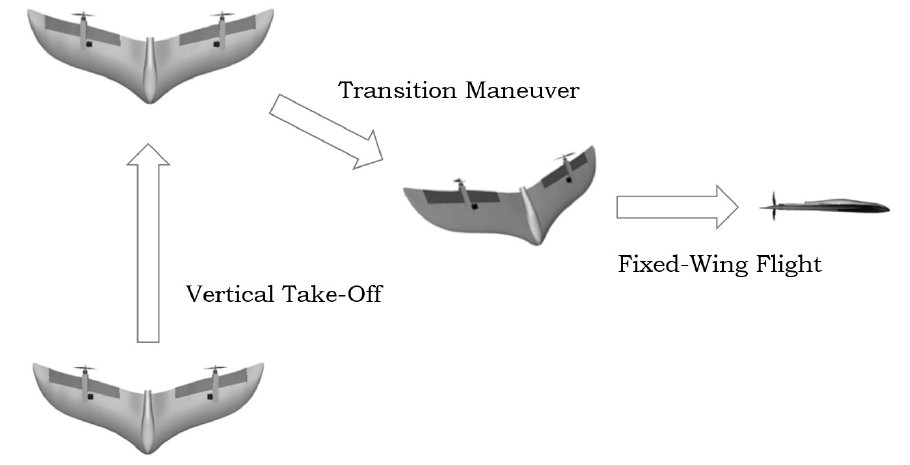
Figure 1. Scheme of the transition maneuver between flight